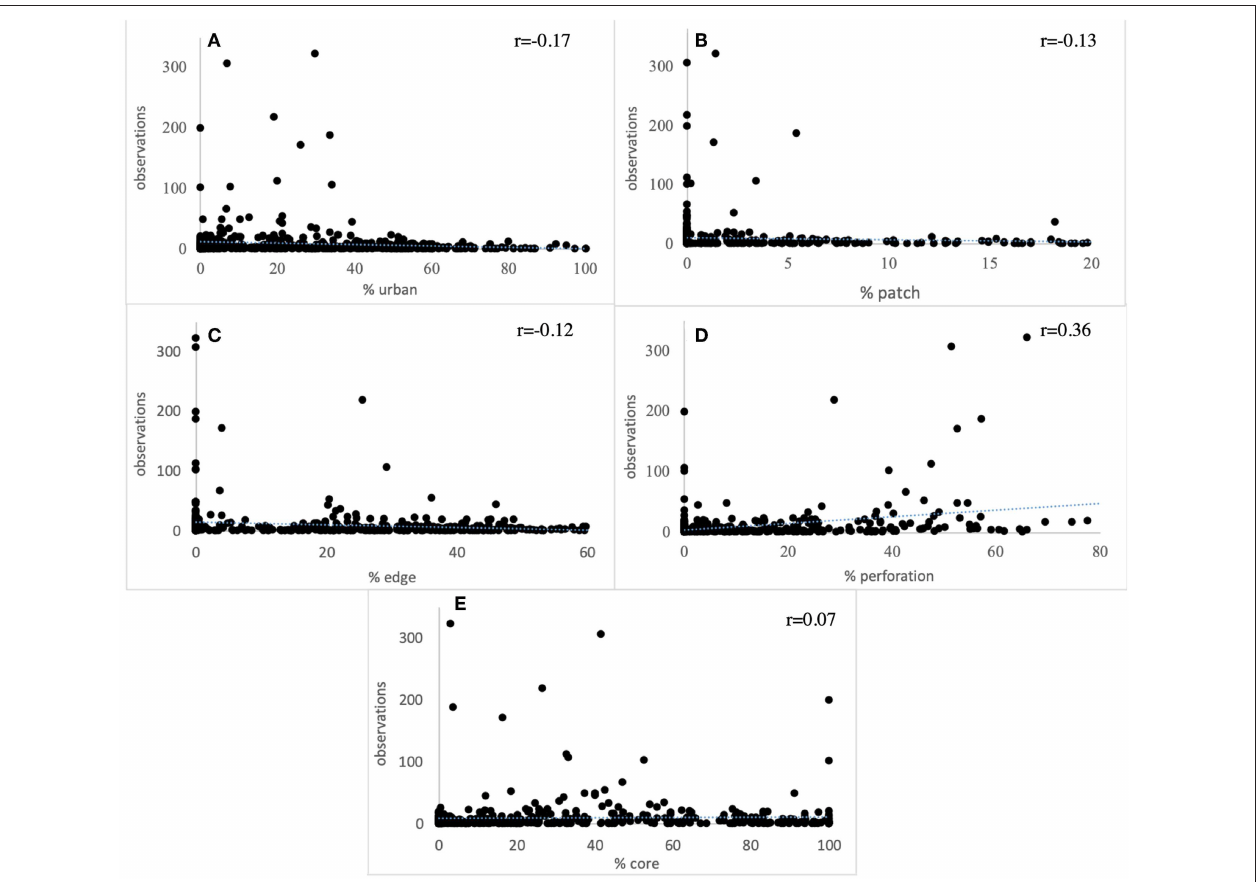
FIGURE 6 | Time spent traveling from schools and other facilities to the main university building in 1954 and 2015. Error bars refer to standard deviation.